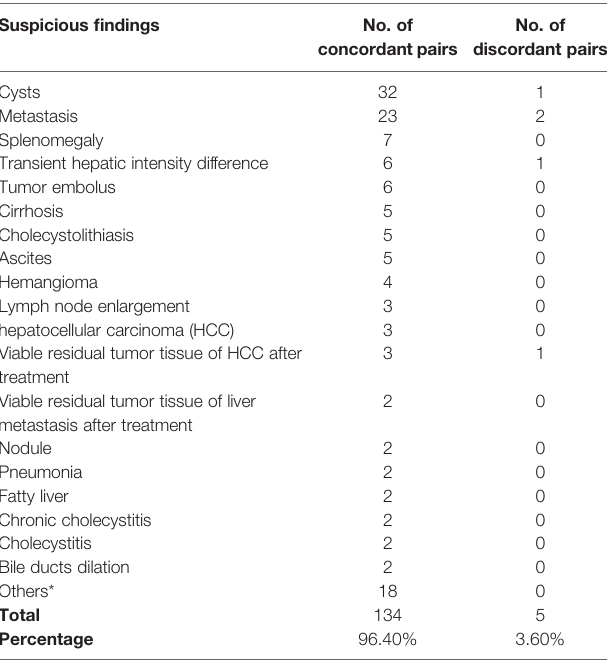
TABLE 4 | Results of concordance analysis between the two liver protocols for the detection of suspicious fi ndings. Suspicious fi